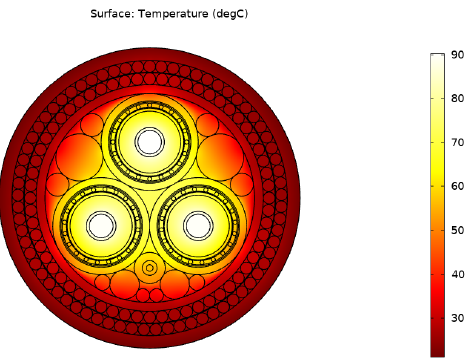
Figure 14. Simulation of the DSEC steady-state temperature distribution (°C) under rated load conditions.